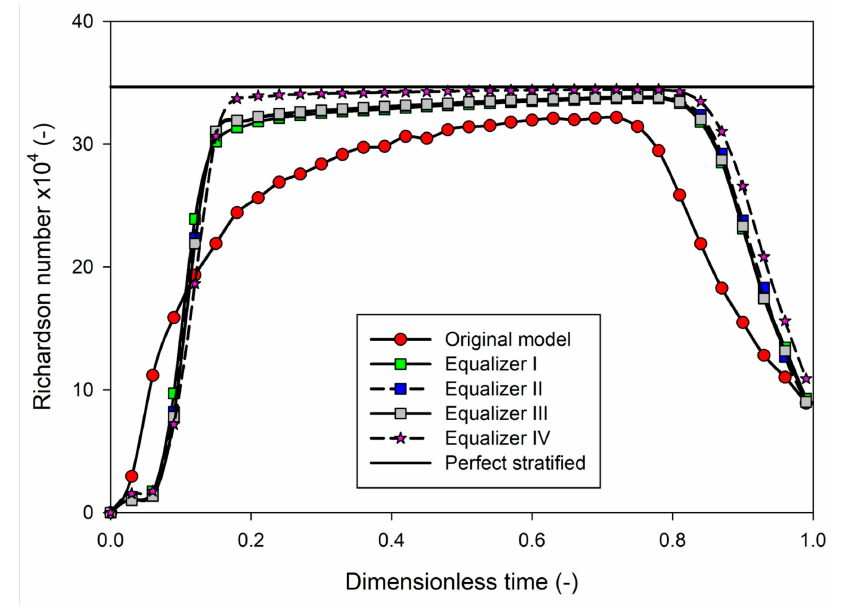
Figure 13. The Richardson numbers for the equalizer